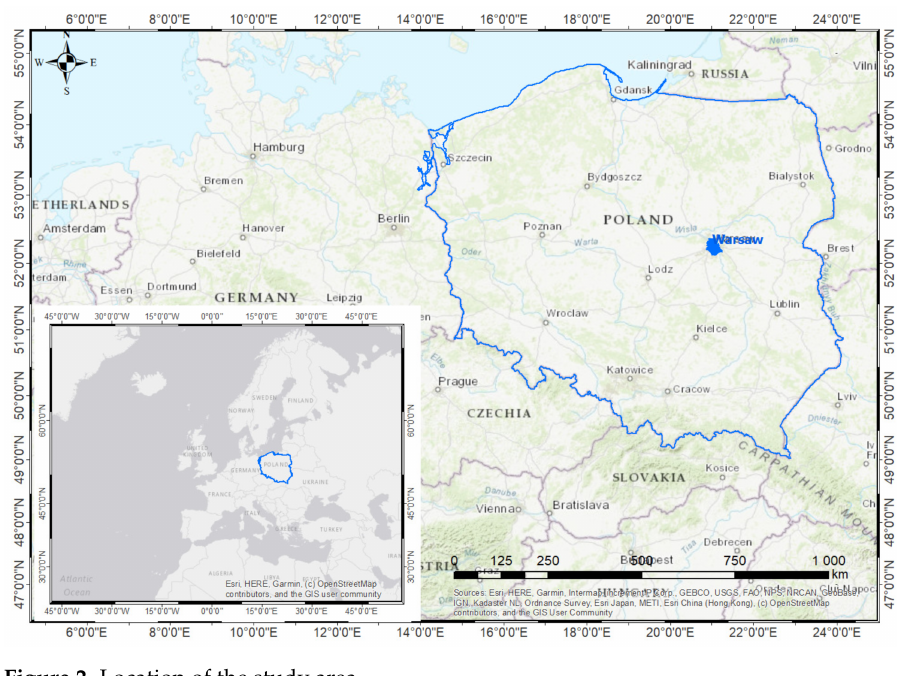
Figure 2. Location of the study area.